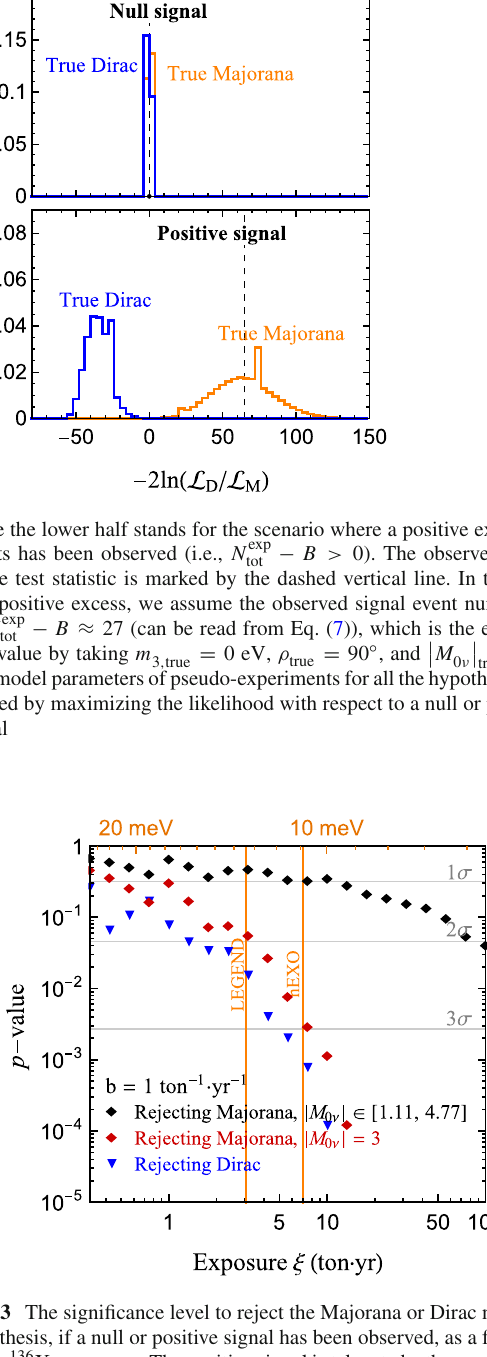
Fig. 3 The significance level to reject the Majorana or Dirac neutrino hypothesis, if a null or positive signal has been observed, as a function of the 136 Xe exposure. The positive signal is taken to be the expectation (cid:2) (cid:2) (cid:2) (cid:2) M = 0 eV, ρ = 90 ◦ and = 3 with by choosing m true 3 , true 0 ν true other oscillation parameters in their NuFIT 5.1 best fits. As usual, the background index is fixed as b = 1 ton − 1 · year − 1 with a full detection efficiency. The 90% C. L. sensitivity to | m ee | for the corresponding exposure is indicated on the top axis. The sensitivities of LEGEND [97] and nEXO [33] to | m ee | with averaged NMEs are shown as the vertical orange lines, which should be interpreted with the top